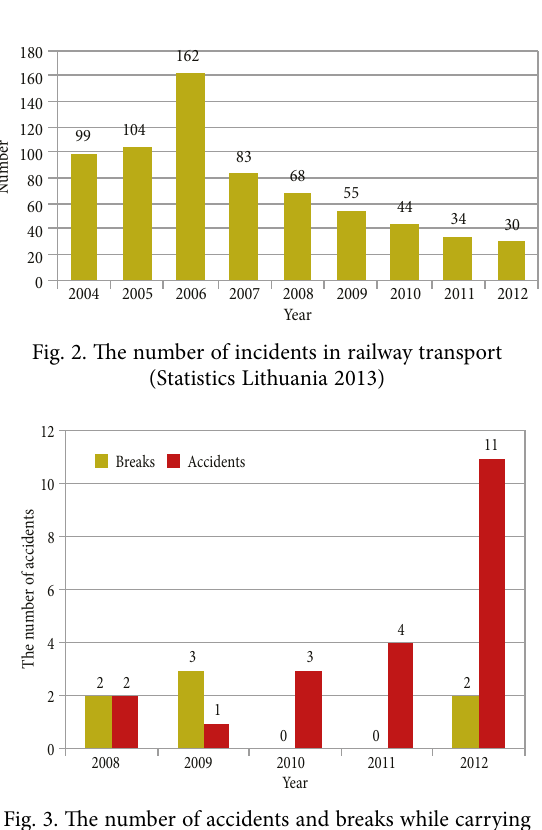
Fig. 3. The number of accidents and breaks while carrying dangerous goods (EuroStat 2014)